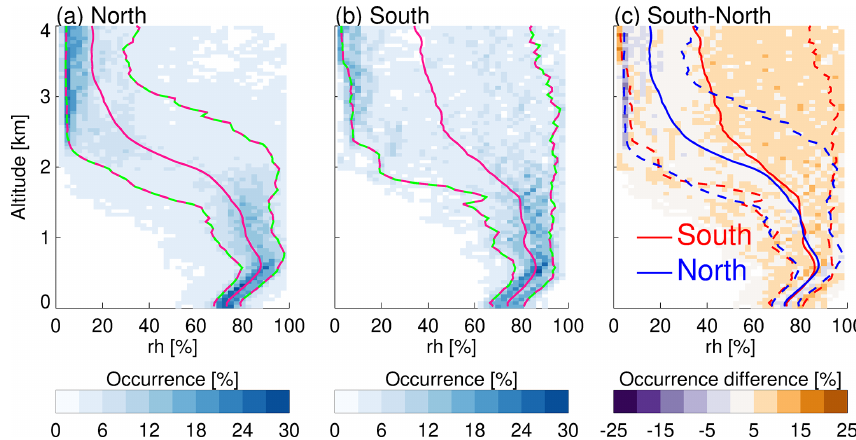
Figure 13. Occurrences of relative humidity as a function of height below 4km for soundings launched between 26 January and 12 February. The sum of occurrence frequencies in each altitude bin is 100%. Altitude bins are 50m deep, and each x axis contains 40 bins. North (a) designates soundings from the northern (12.5–14.5 ◦ N; 261 profiles) latitude band, and south (b) designates soundings from the southern (8.5–10.5 ◦ N; 63 profiles) latitude band. Solid lines show the mean profiles in each region, and dashed lines the 10th and the 90th percentiles. Only data from ascending radiosondes are used in this comparison. The difference between north and south is shown in panel (c) with the lines from panels (a) and (b)